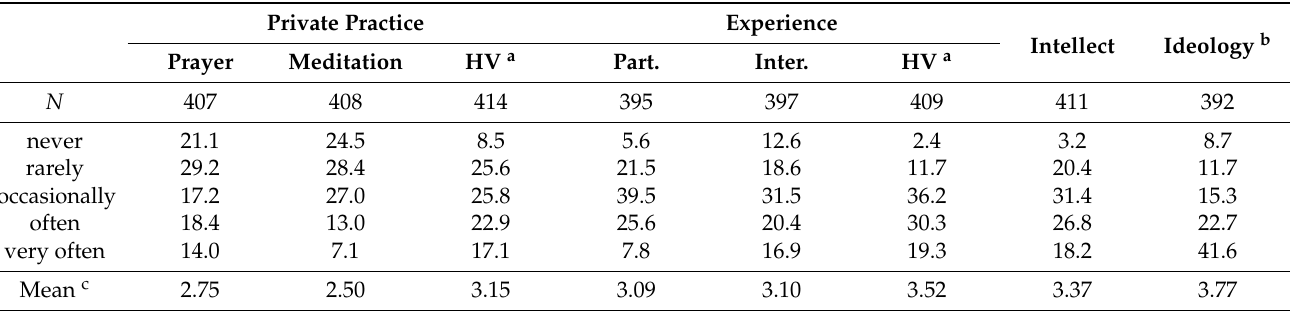
Table 4. Percentage distribution of responses and mean values of the six indicators on the four core dimensions of private practice, experience, intellect, and ideology among German-speaking pilgrims.